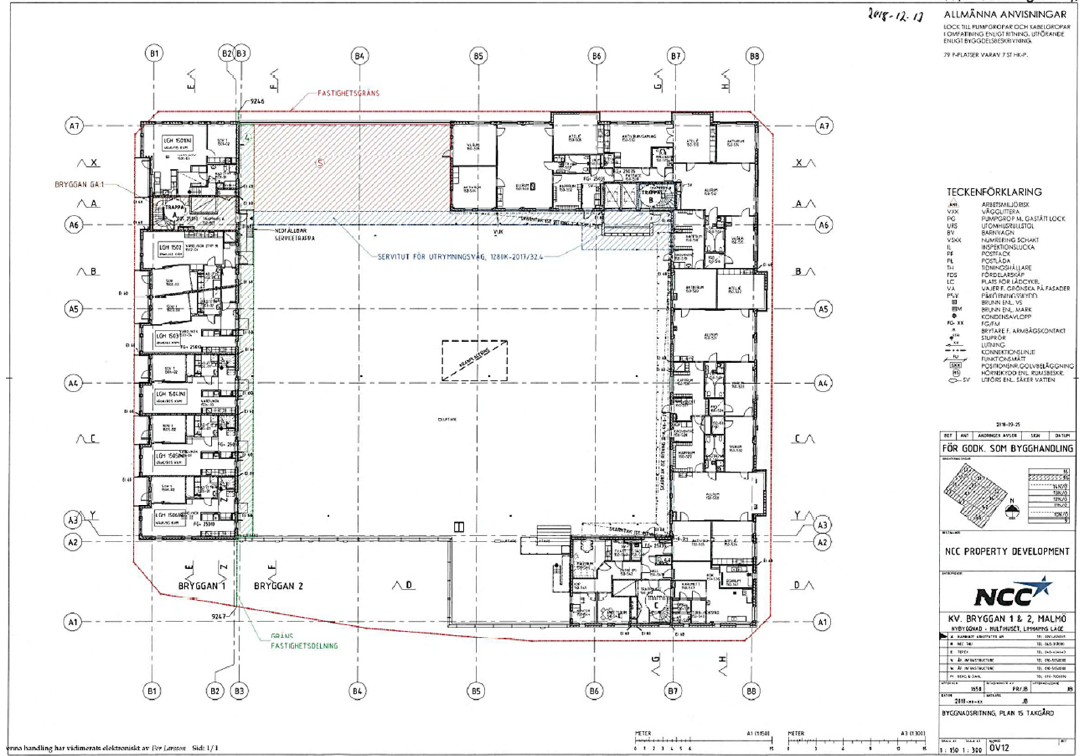
Figure 8. Example of computer aided design (CAD) construction plans in Multihuset as part of the actual property formation dossier, green lines representing property boundaries (Source: NCC Company).